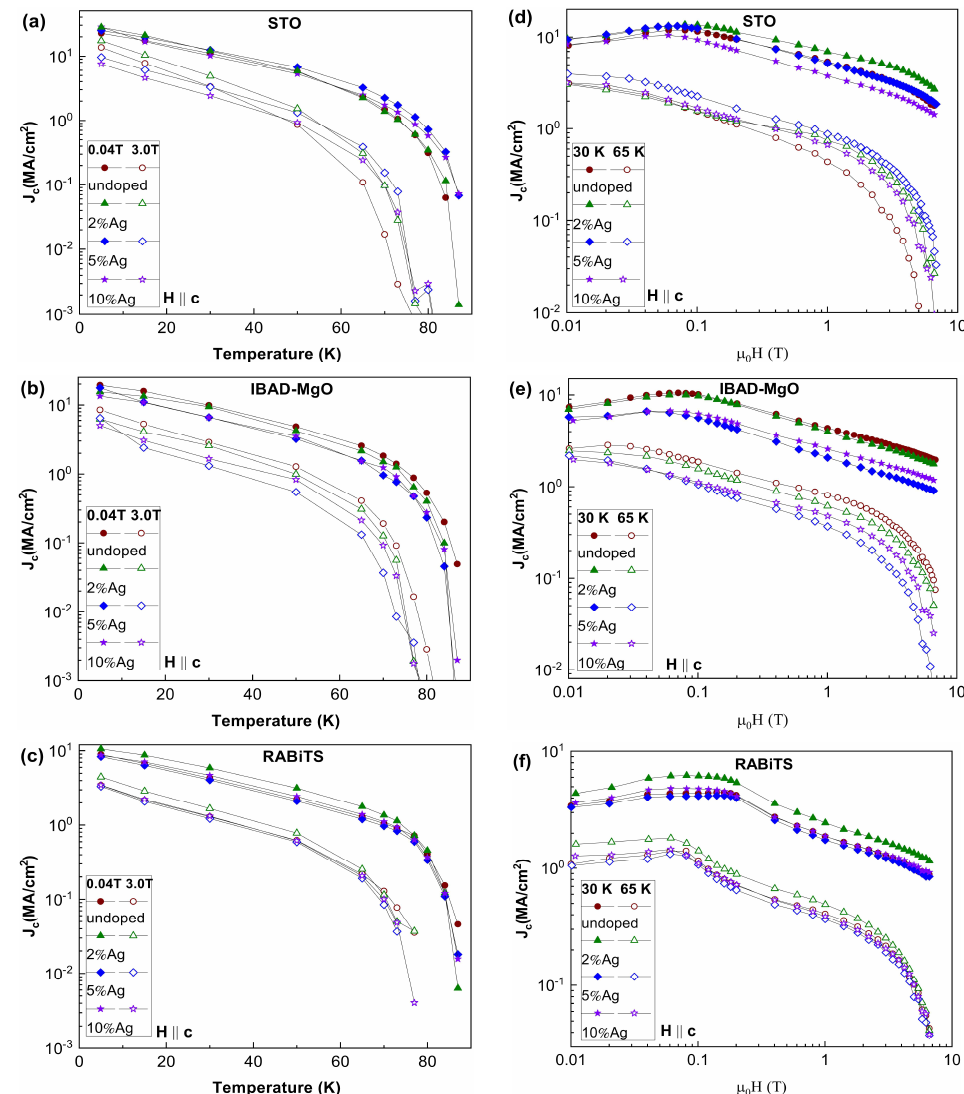
Figure 6. Dependence of the critical current density J c on the ( a – c ) temperature and ( d – f ) magnetic field for undoped and Ag−doped YBCO films deposited on different templates.